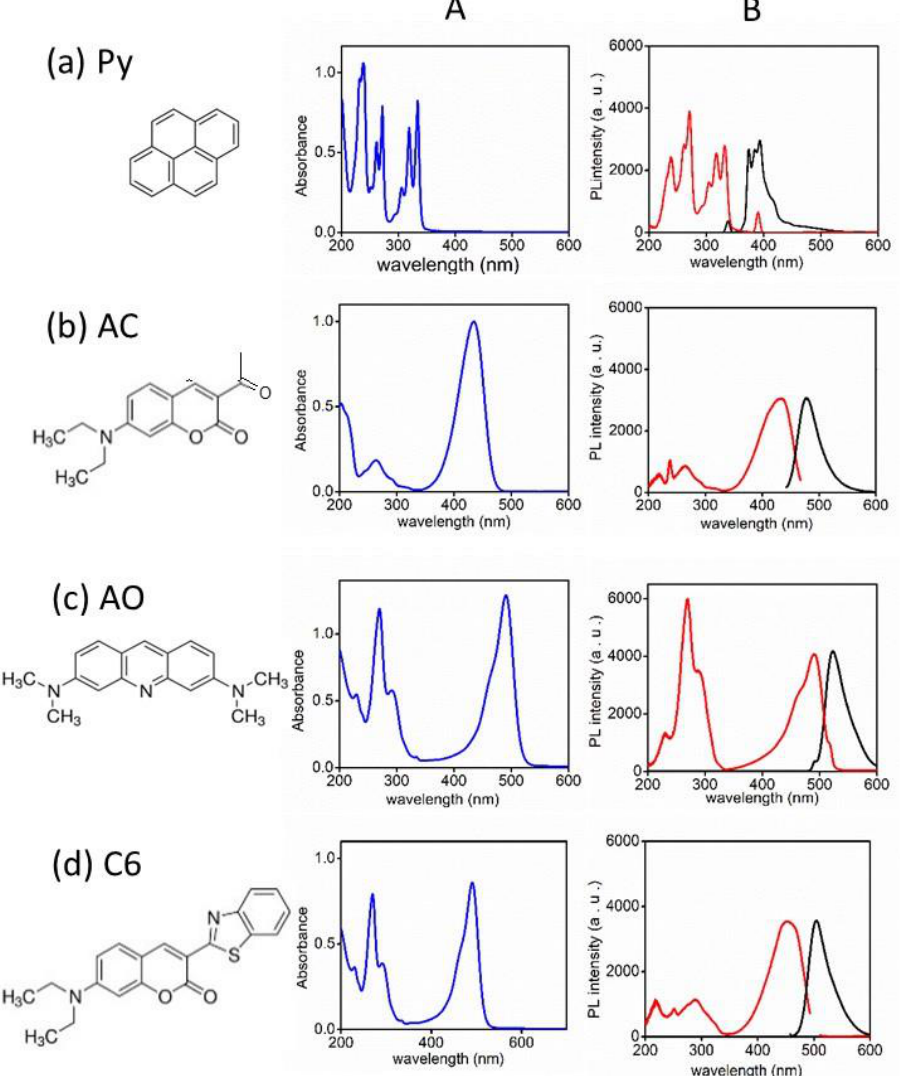
Figure 2. ( A ) UV-visible absorption spectra and ( B ) fluorescence excitation and emission spectra. ( a ) Py, ( b ) AC, ( c ) AO, and ( d ) C6. The concentration of each solution is 10 μM.